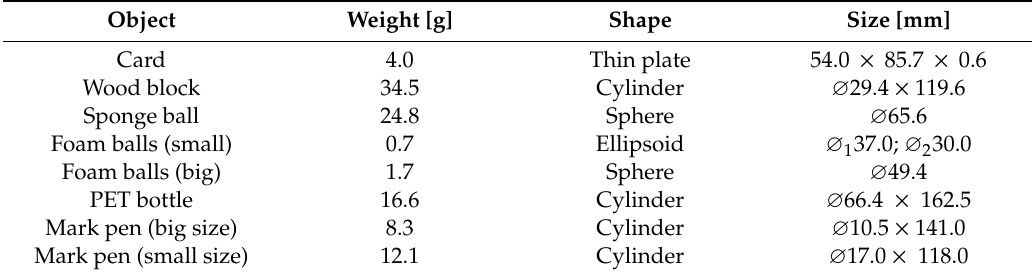
Table 2. List of experimental